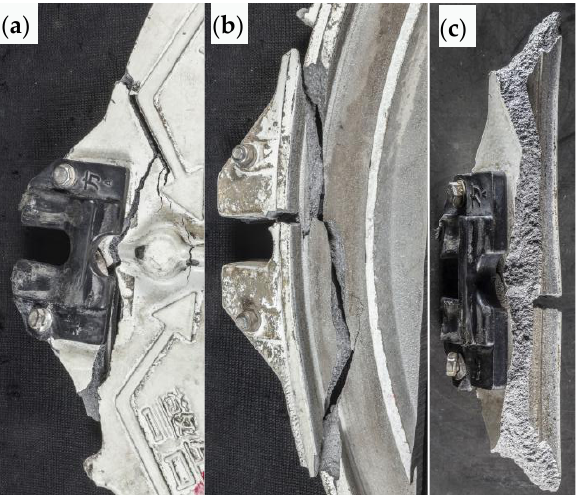
Figure 5. Macro morphology of safety buckle fracture surface: ( a , b ) external surface and internal cavity surface morphology, respectively, of cracked block after assembly, ( c ) macromorphology of crack surface.